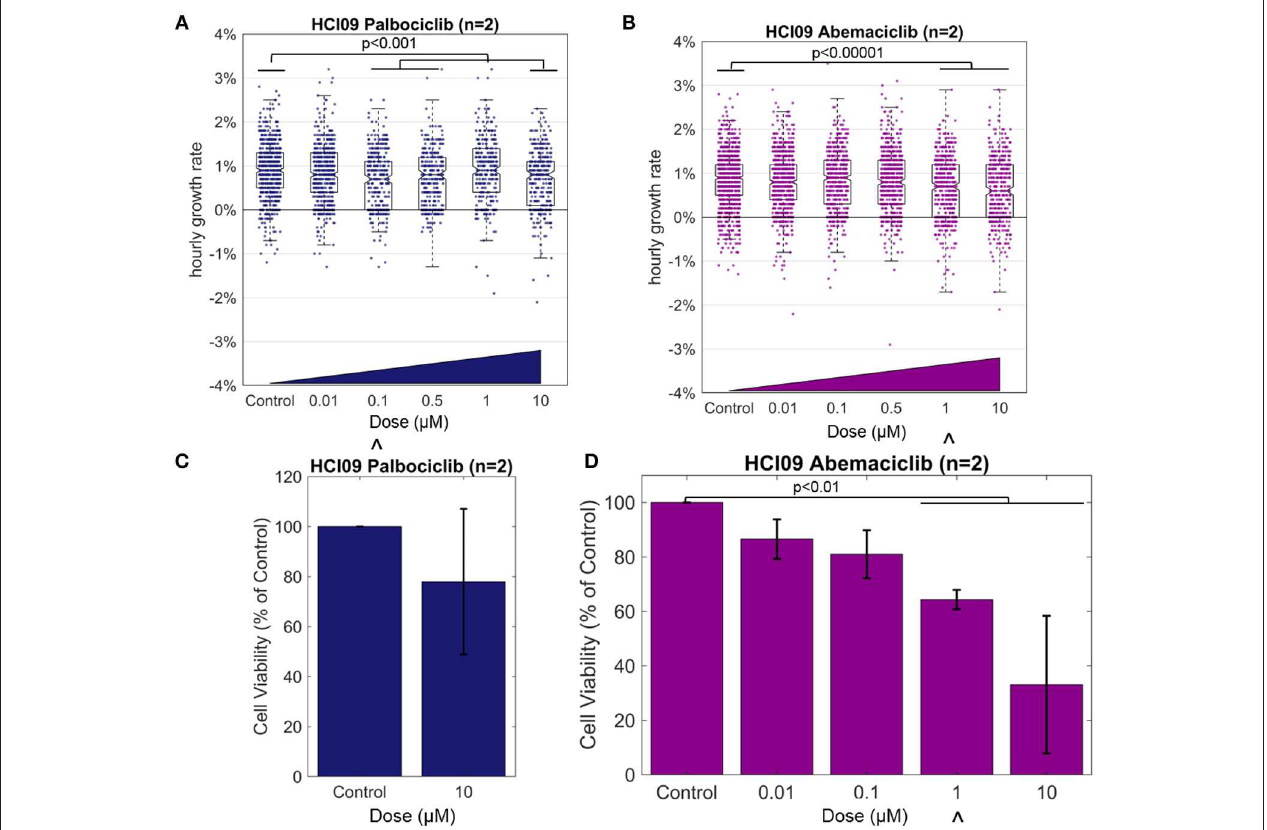
FIGURE 4 | Effect of the CDK4/6 inhibitors on TNBC PDX HCI09, measured by HSLCI (A,B) and standard luciferase assays (C,D) . Individual dots in the overlaying the box plot represent the mass accumulation rates of single cells measured over the interval 24–40h post-dosing. Box-plot notches are indicative of 95% confidence intervals for the medians. The “ ∧ ” symbol indicates the in vitro dose that corresponds to the maximum tolerated serum concentration in humans [ 18]. In HSLCI experiments, the data shown was pooled from two replicates. In (C,D) , error bars represent standard deviation. Two sample t -tests were performed between all populations compared to the control